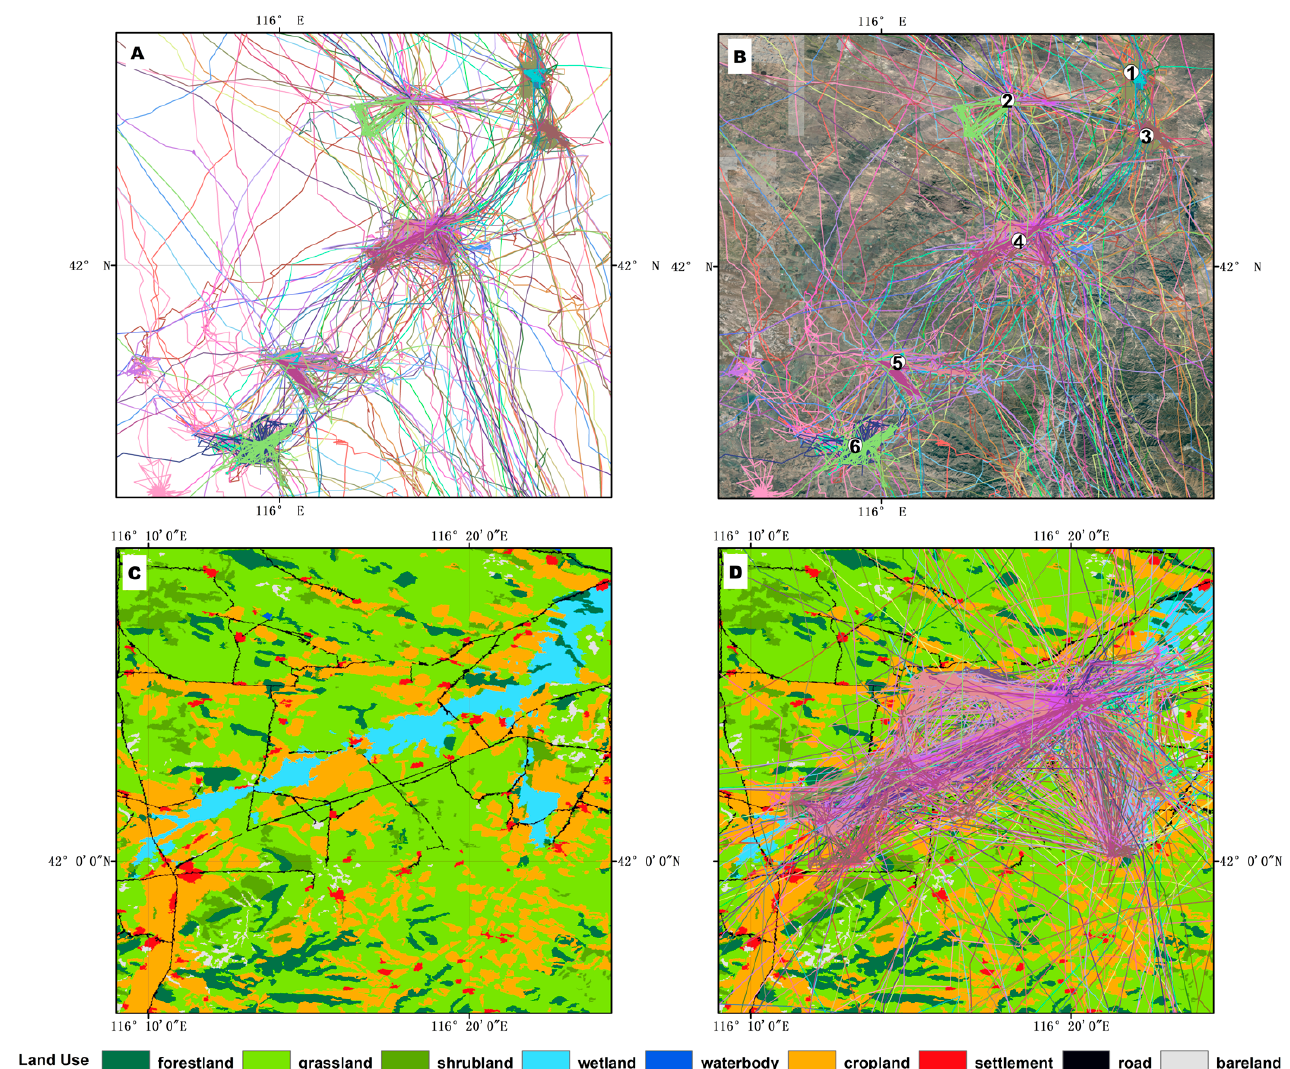
Figure 4 Movements and distribution of Mongolian–Chinese white-naped cranes Figure 4. Movements and distribution of Mongolian–Chinese white-naped cranes Antigone vipio at their major stopover Antigone vipio at their major stopover sites in the Luan River catchment. A shows sites in the Luan River catchment. ( A ) shows movement trajectories for 39 birds in different colours; ( B ) shows the location movement trajectories for 39 birds in different colours; B shows the location of six critical of six critical sites distribution in the Luan River catchment overlaid on a satellite image; ( C ) is a more detailed land use sites distribution in the Luan River catchment overlaid on a satellite image; C is a more map for critical site No.4 identified in ( B ); ( D ) shows movement trajectories overlaid on the land use map (see Table 3 for detailed land use map for critical site No.4 identified in B; D shows movement habitat use at this trajectories overlaid on the land use map (see Table 3 for habitat use at this time).